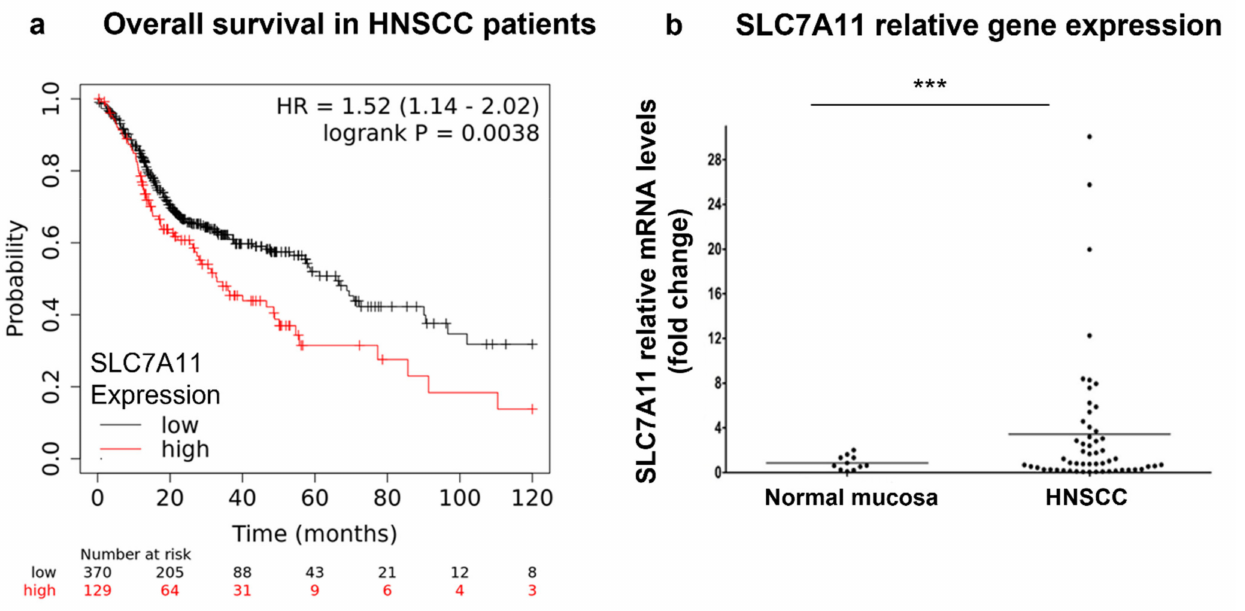
Figure 1. xCT (SLC7A11) expression in patients with HNSCC. The prognostic value of xCT (SLC7A11) mRNA was evaluated in patients with HNSCC using the KMplot database (https://kmplot.com/ analysis/), and correlation between the levels of xCT (SLC7A11) and overall survival rate is displayed on the plot diagram ( a ). Relative xCT (SLC7A11) mRNA levels in tissue specimens of patients with HNSCC and control healthy mucosa were determined using real-time PCR analysis ( b ). Relative quantities of the transcripts were calculated via pairwise differences of threshold cycles ( ∆ CT) of the SLC7A11 gene and the loading control GAPDH housekeeping gene. *** p <